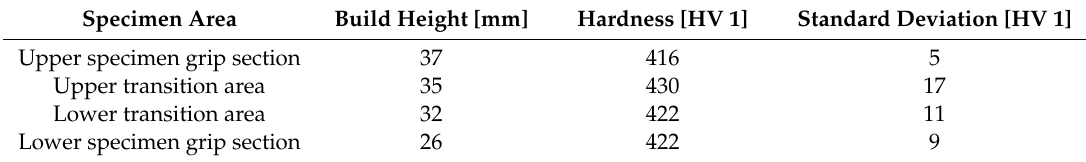
Table 2. Vickers hardness distribution over build height for a strut with a 2 mm diameter.